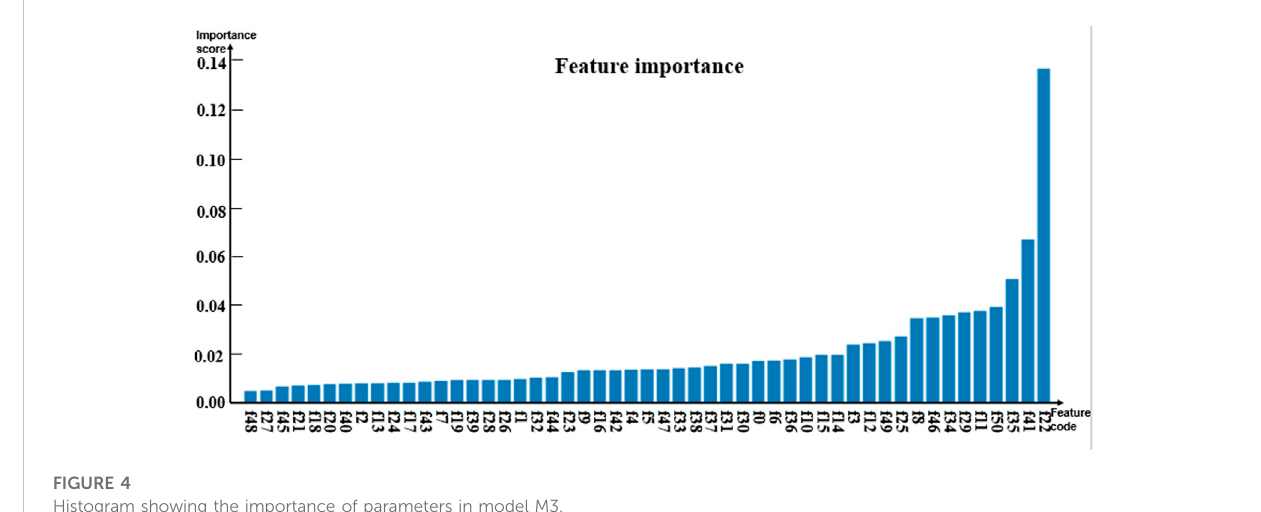
FIGURE 4 Histogram showing the importance of parameters in model M3.